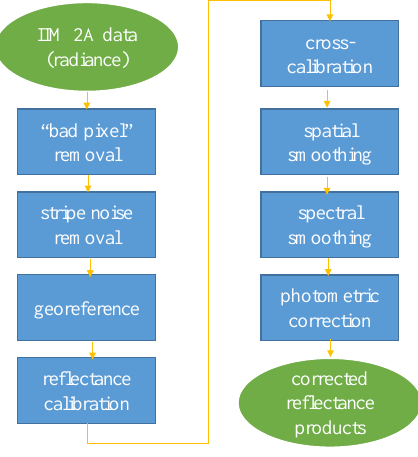
Figure 5. - IIM pre-processing workflow.